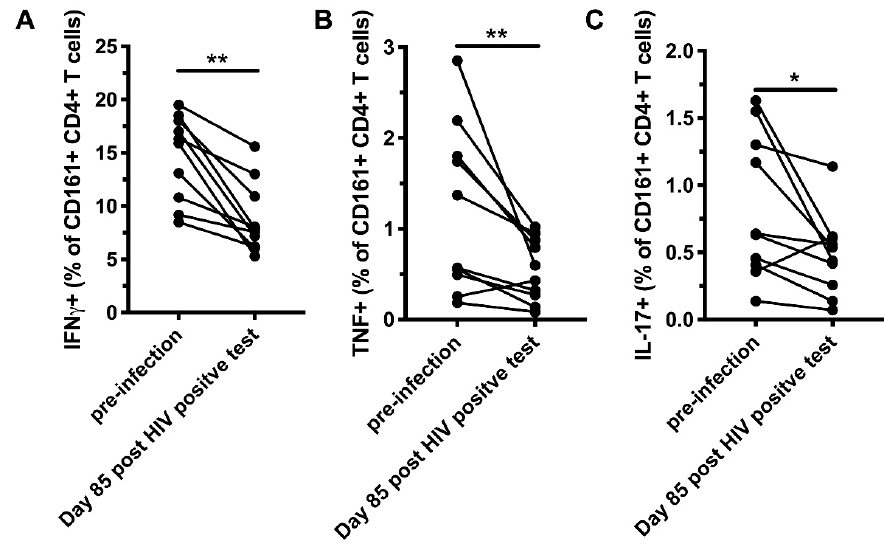
Figure 3. Peripheral blood CD161 + CD4 + T cells are reduced early in HIV-1 infection. Representative flow plots showing expression of CD161 by CD4 + T cells in blood in acute, untreated HIV-1 infection ( A ). Frequency ( B ) and absolute cell count ( C ) of peripheral blood CD4 + T cells expressing CD161 during untreated, acute HIV-1 infection (AHI). Individual subjects are shown in grey and the median in blue. Time points sampled are indicated by the circles. The red line represents the median viral load. Absolute cell count of peripheral blood cells in acute untreated HIV-1 infection. Expression of HLA-DR ( D ), CD38 ( E ), TIGIT ( F ), and PD-1 ( G ), by peripheral blood CD161 + CD4 + T cells in acute, untreated HIV-1 infection. Association between VL 16 days post-first HIV RNA test, and frequency of peripheral CD4 + T cells expressing CD161 ( H ). Associations between VL at day 85 post-first HIV RNA-positive test and expression of HLA-DR by CD161 + CD4 + T cells ( I ). n = 20 for all plots except for ( C ) ( n = 15) and ( H ) ( n = 17). * p < 0.05, ** p < 0.01, and *** p < 0.001.